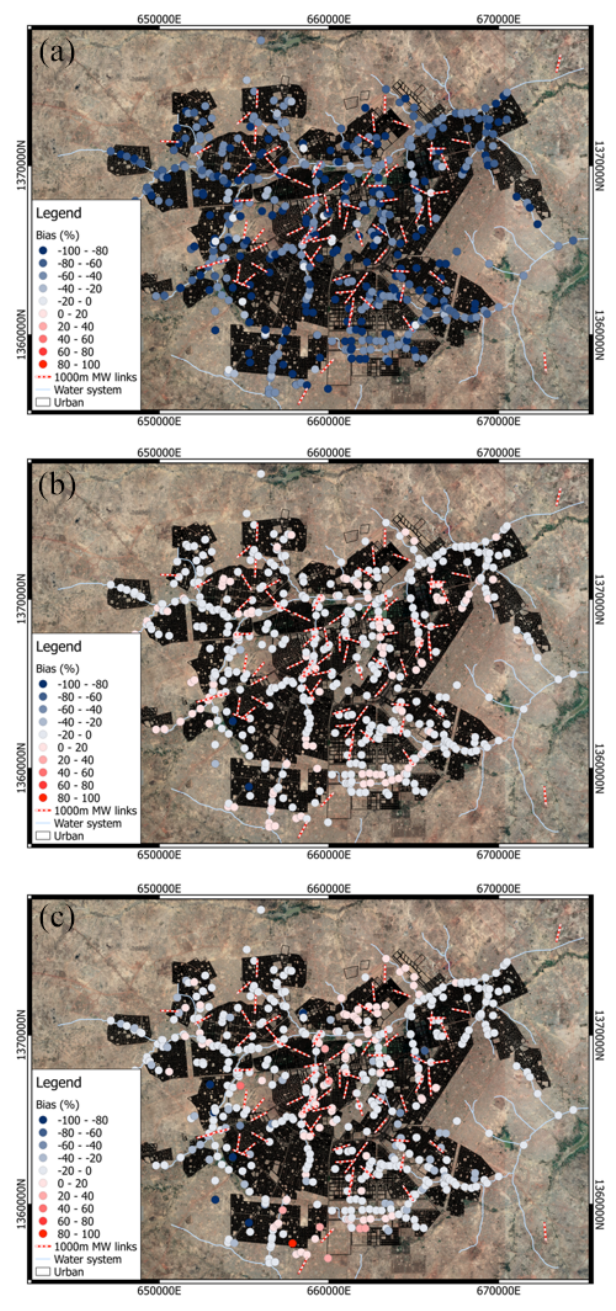
Figure 1. Map of the bias (%) between the simulated discharge when the CML network provides perfect accuracy on the attenua- tion (reference) and the simulated discharge with less accurate mea- surement of CML attenuation (1dB or 0.1dB). (a) CML configura- tion with 6GHz frequency and 0.1dB precision. (b) CML configu- ration with 30GHz and 0.1dB. (c) CML configuration with 30GHz and 1dB. Map background information provided by © Google Maps and © OpenStreetMap contributors 2016. Distributed